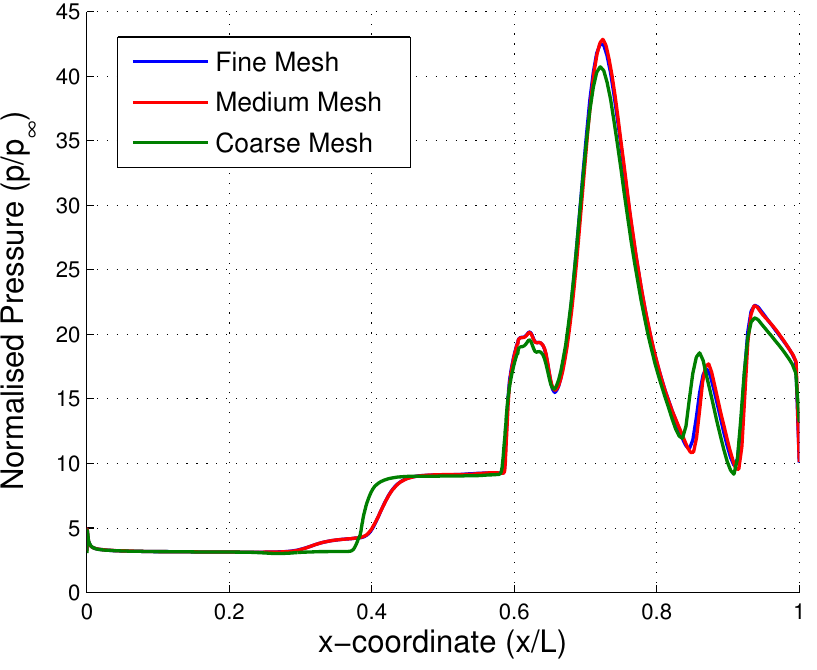
Figure 11. Normalized static pressure along the centerline for the baseline scramjet inlet-isolator model using different mesh grid